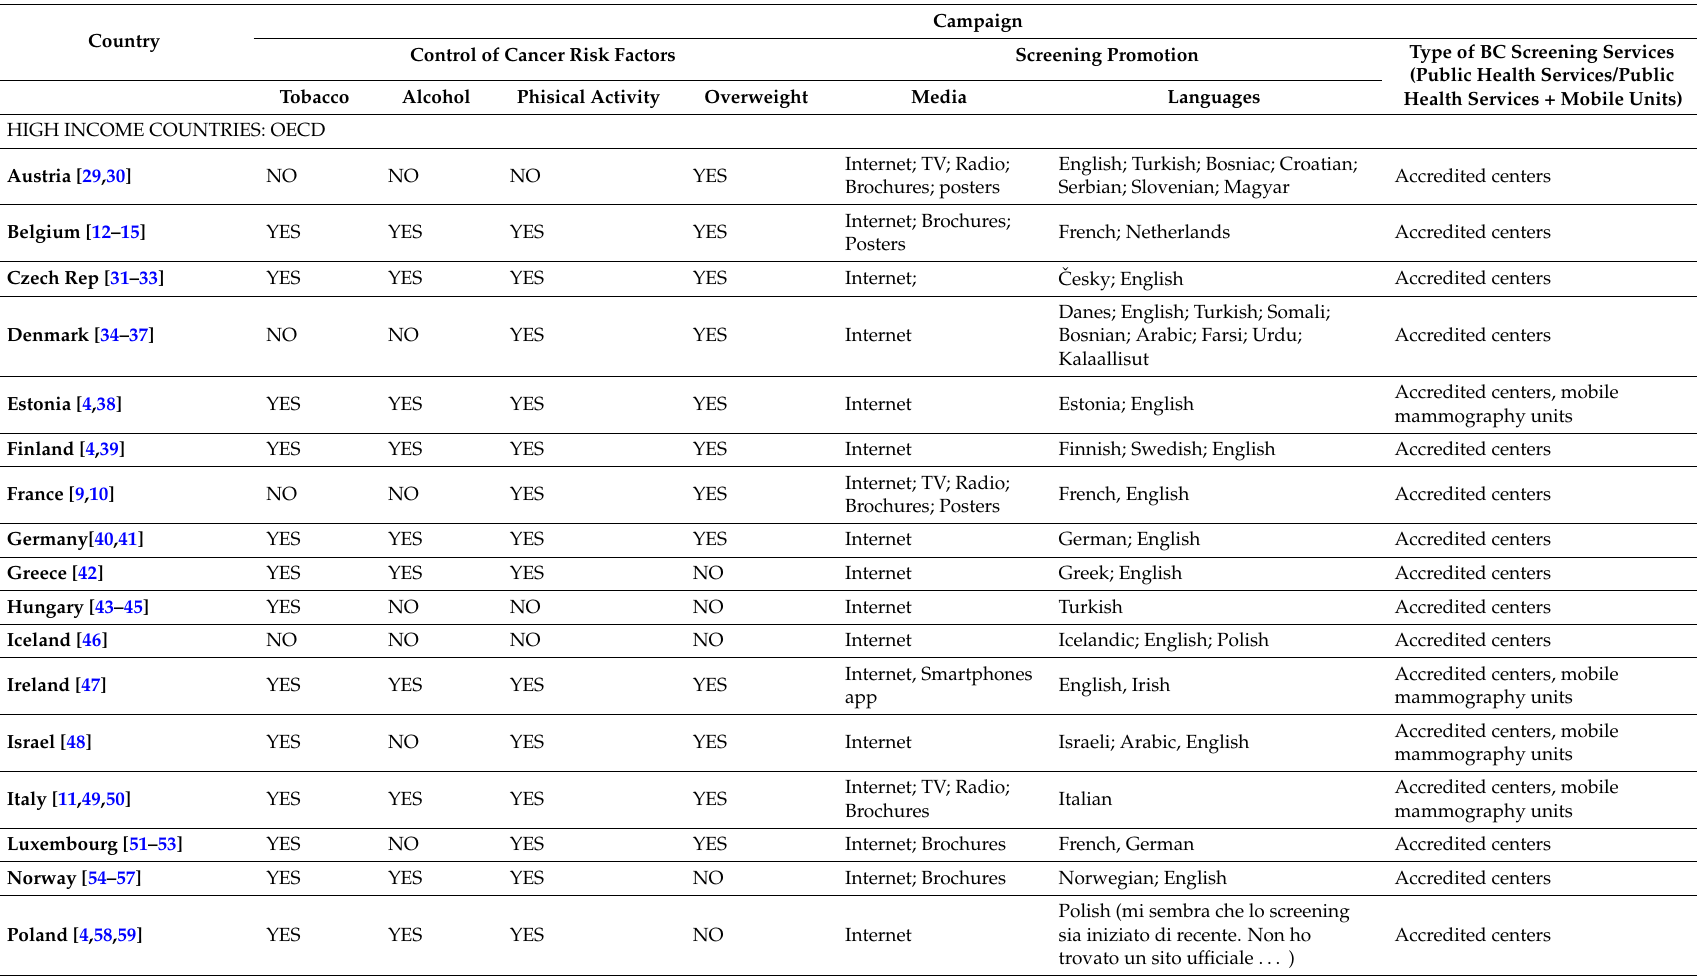
Table 2. Campaigns of primary prevention and screening promotion in 53 WHO European